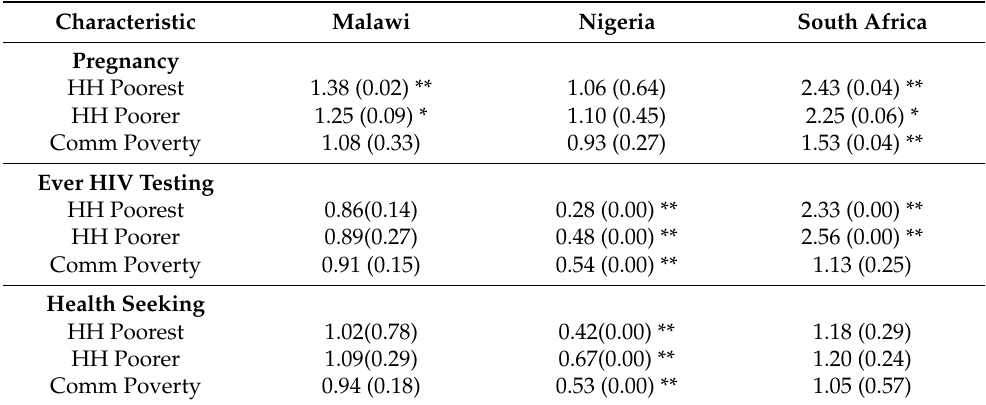
Table 2. The adjusted association between poverty and health outcomes among young women in Malawi, Nigeria and South Africa. Characteristic Malawi Nigeria South Africa